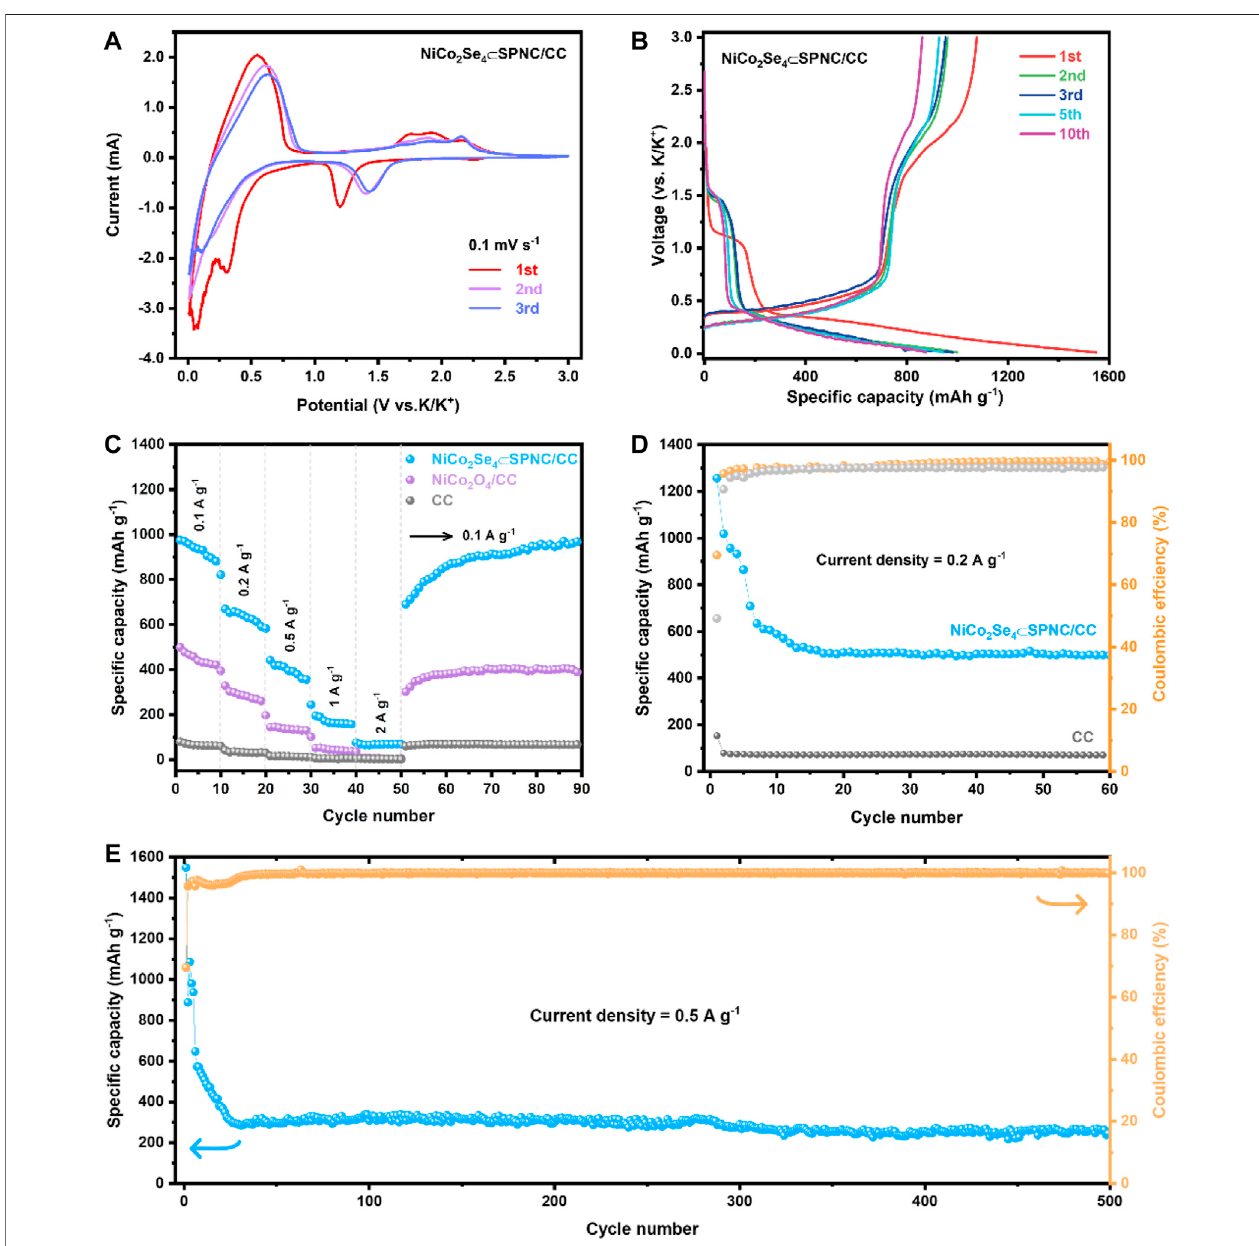
FIGURE 4 | (A) CV curves of the NiCo 2 Se 4 ⊂ SPNC/CC anode at different scan rates, electrode for the fi rst three circles at 0.1 mV s − 1 , (B) GCD curves for the NiCo 2 Se 4 ⊂ SPNC/CC electrode in the different circles at a current density of 0.1 A g − 1 , (C) Rate performances of the NiCo 2 Se 4 ⊂ SPNC/CC electrode, (D) Cycle performance and Coulombic ef fi ciency of CC and NiCo 2 Se 4 ⊂ SPNC/CC at a current density of 0.2 A g − 1 , and (E) Long-term cycling performances of